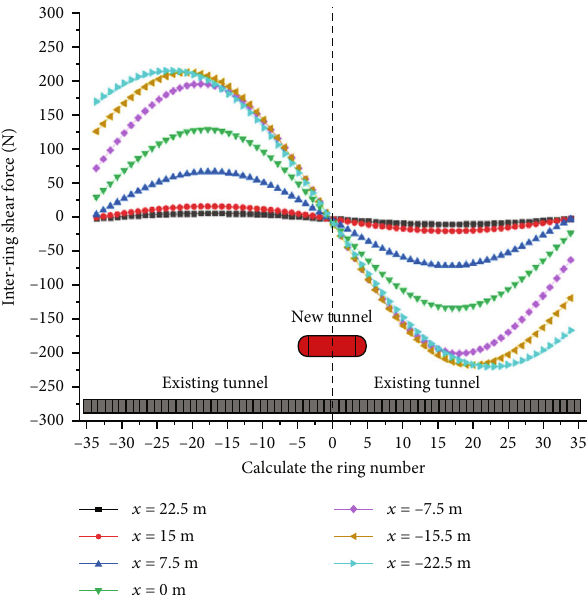
Figure 17: Shearing force between shield tunnel segments.